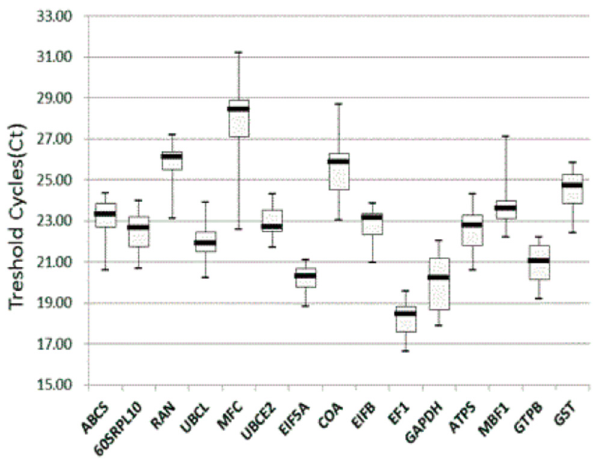
Fig 3. Threshold cycle (Ct) values of the candidate RGs across the experimental samples. A box-plot graph of Ct values shows the median values as lines across the box. Upper and lower boxes indicate the 75th percentile to the 25th percentile. Whiskers represent the maximum and minimum